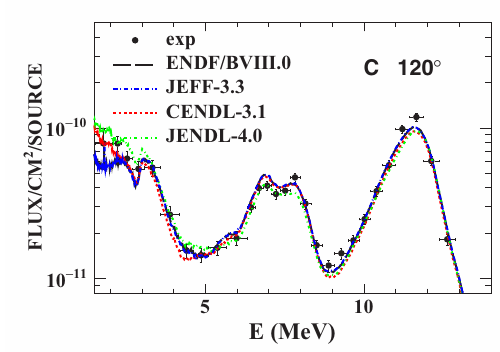
Figure 2. Neutron leakage spectra for Ga sample at 60 ◦ .